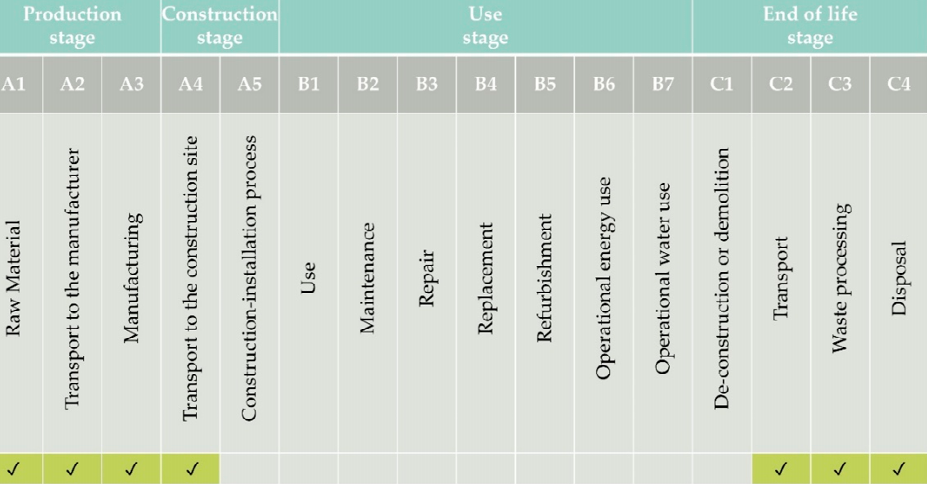
Figure 1. Life cycle stages considered for the calculation of the energy payback time (EPBT) and carbon payback time (CPBT) (green marked).